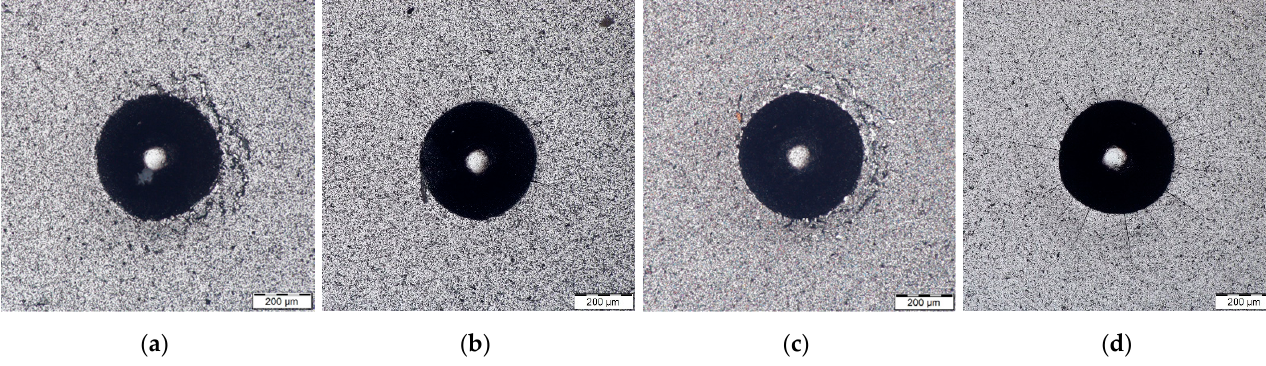
Figure 8. The optical micrograph of Rockwell indentation of the coatings on substrate steel HS6-5-2 with magnification 250×: ( a ) AlCrBN; ( b ) PN/AlCrBN; ( c ) AlCrVN; ( d ) PN/AlCrVN.